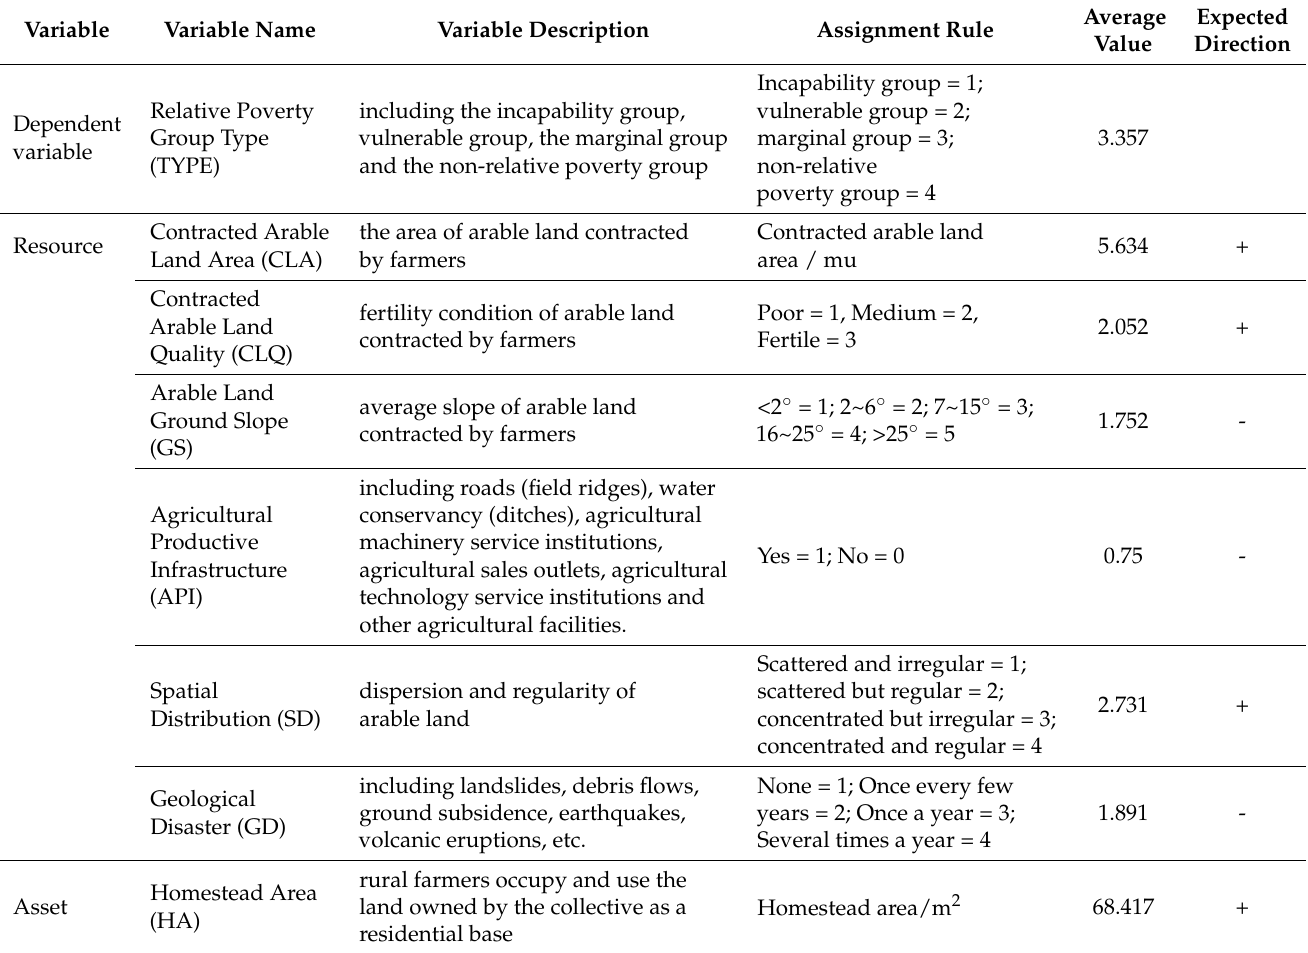
Table 2. Variable meanings and assignment